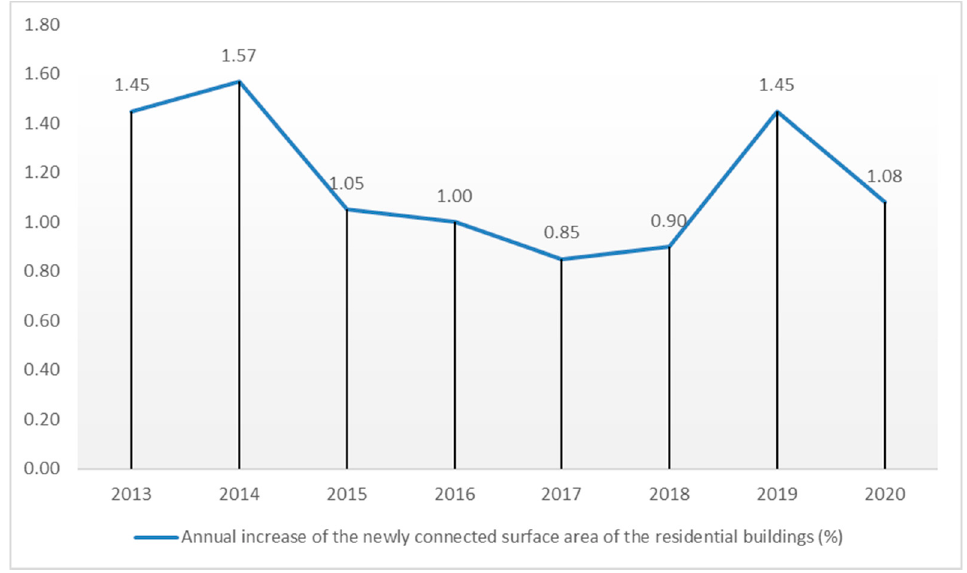
Figure 3. Annual increase of the newly connected surface area of residential buildings.